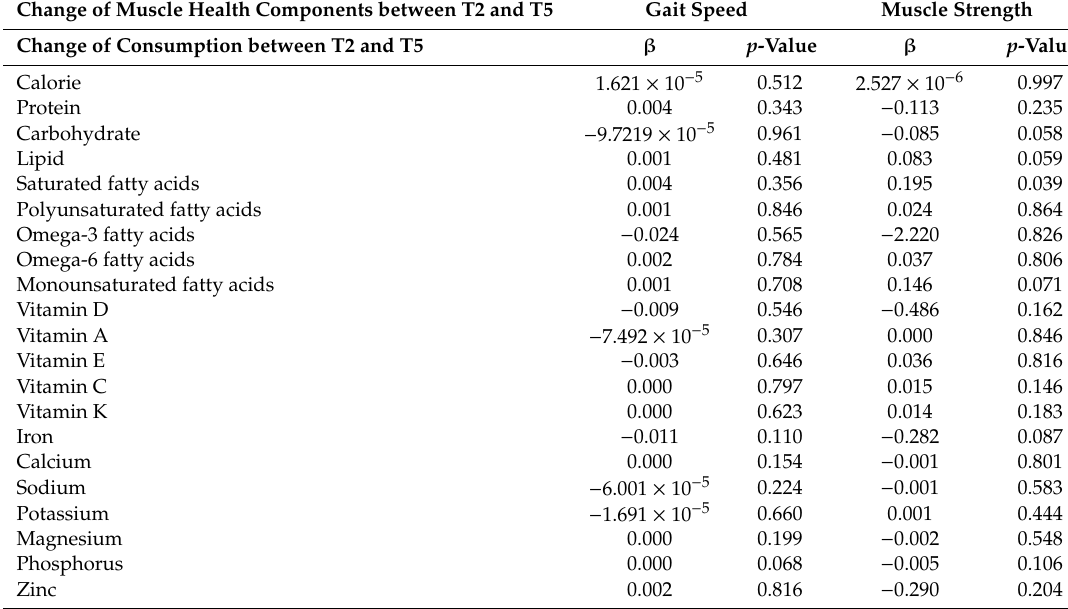
Table A2. Association between longitudinal changes in macro- and micronutrient consumption and longitudinal relative changes in muscle health